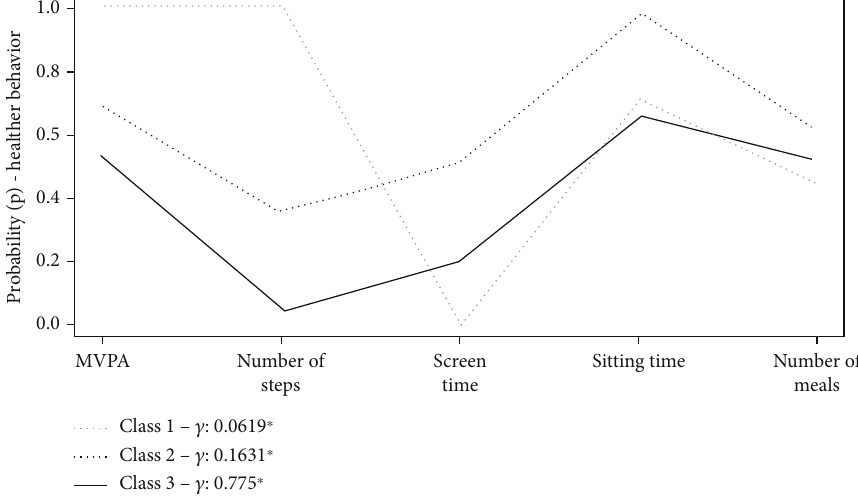
Figure 1: Latent Class Analysis model of female adolescents ’ lifestyle (LS). ∗ Prevalence ( γ ) of latent class. ρ : item-response probability. Class 1: Active & Sedentary LS ( γ = 6 : 19 % ); Class 2: Inactive & Non-Sedentary LS ( γ = 16 : 31 % ); Class 3: Inactive & Sedentary LS ( γ = 77 : 5 % ). MVPA: Moderate to Vigorous Physical